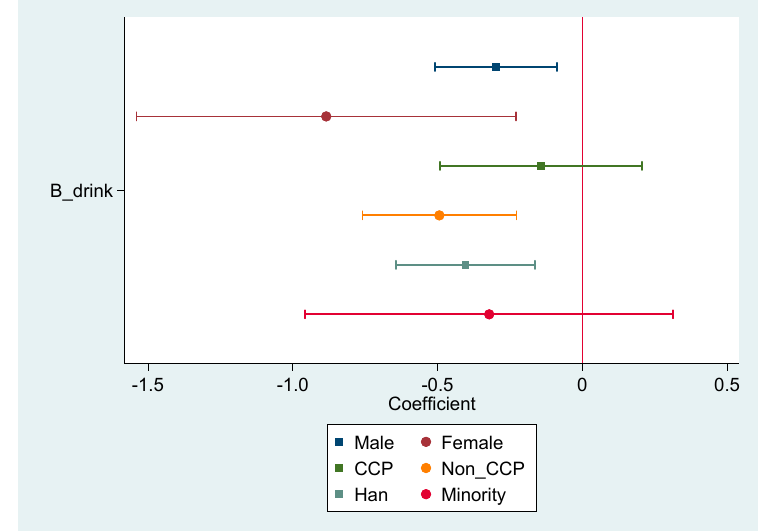
Figure 3. Heterogeneity analysis.